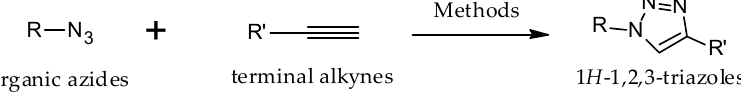
Figure 3. Synthesis of 1 H -1,2,3-triazoles from organic azides and terminal alkynes. Table 1. Synthesis of 1 H -1,2,3-triazole derivatives 1 – 7.